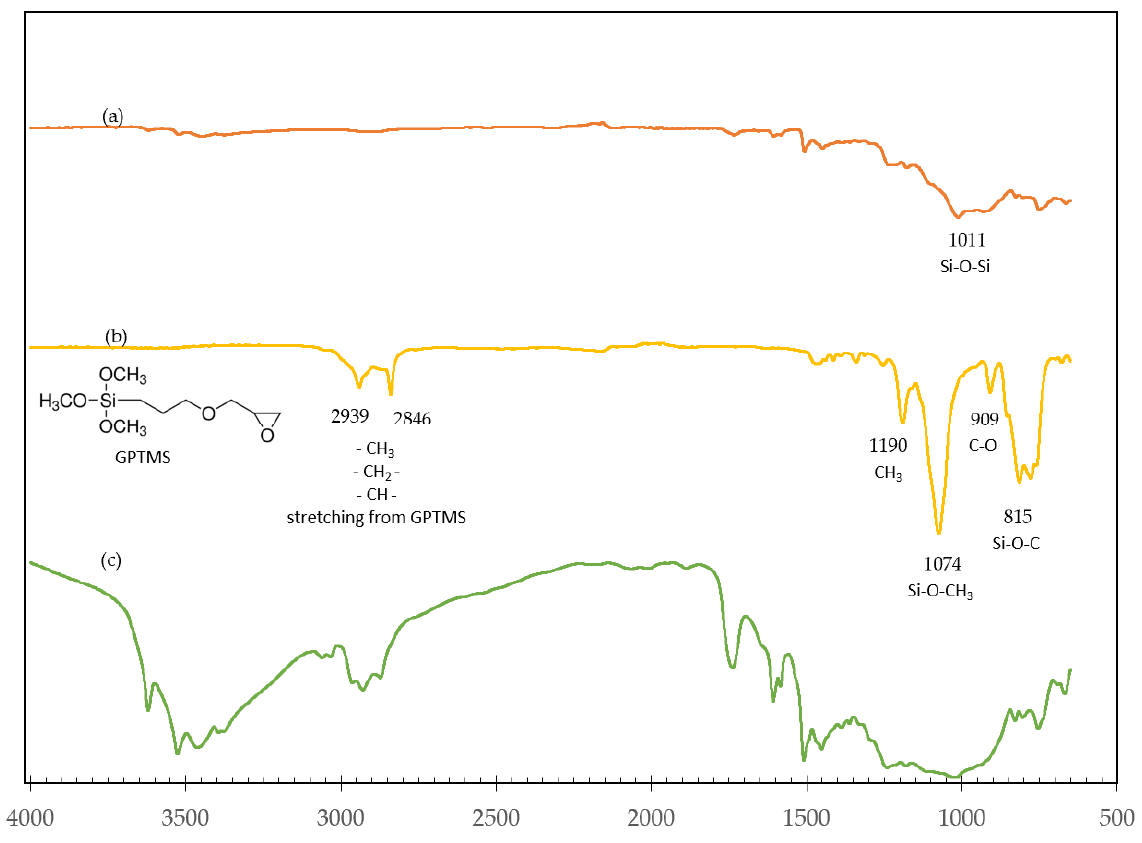
Figure 2. FTIR of ( a ) untreated NMPCB; ( b ) 3-glycidyloxypropyltrimethoxysilane (GPTMS); ( c ) treated NMPCB. ( c ) treated